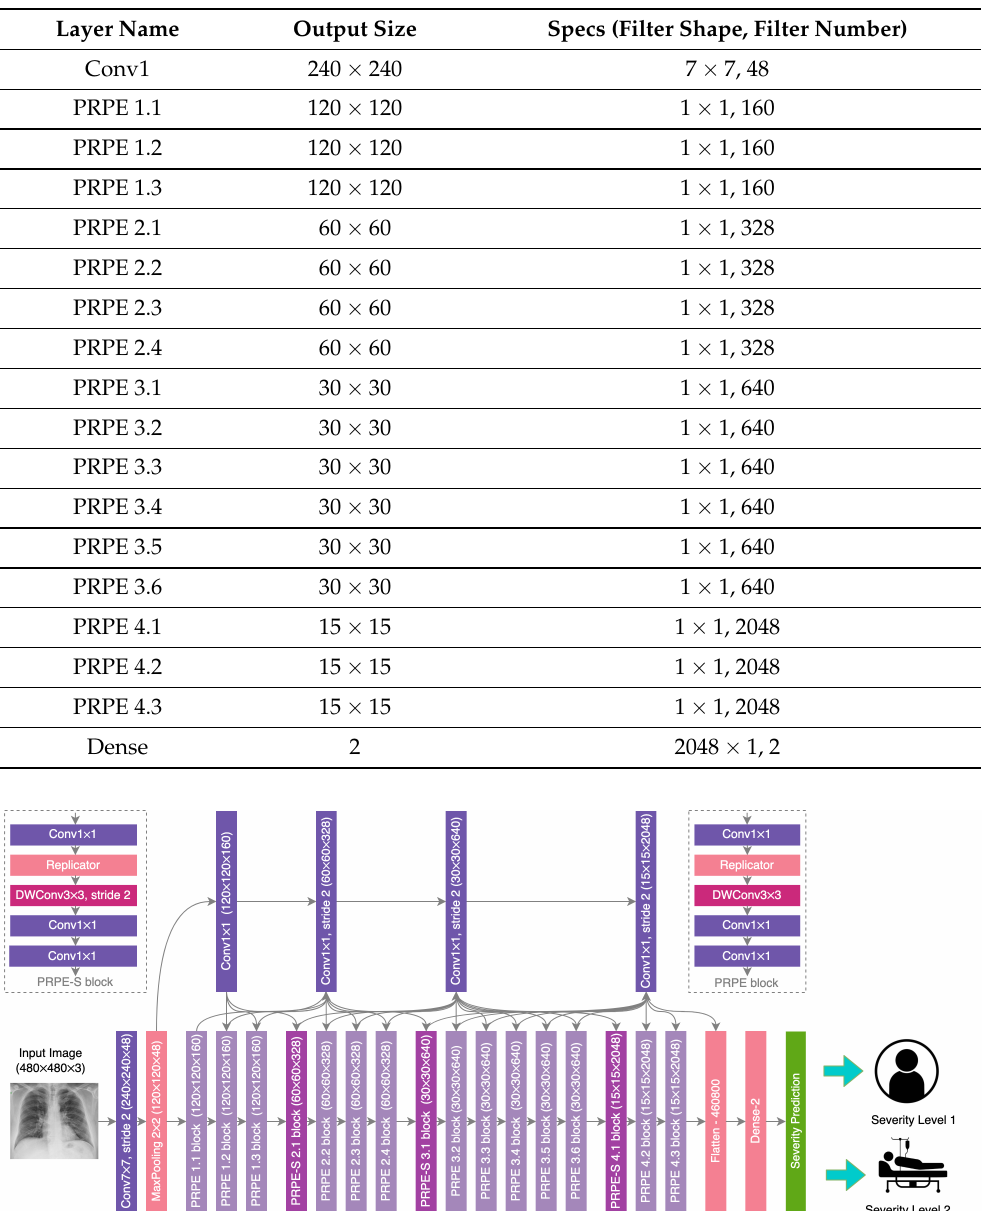
Table 1. Detailed description of each layer of COVID-Net CXR-S architecture. PRPE refers to layer with convolution layer of filter size 1 × 1.